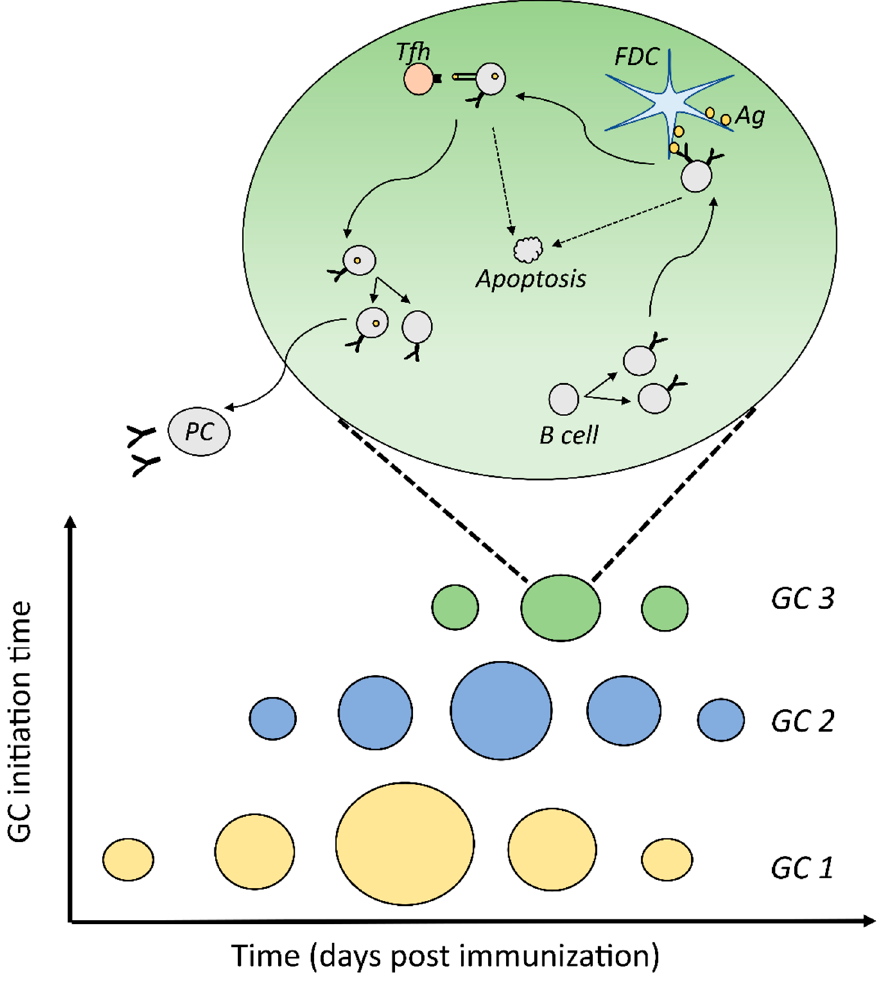
Figure 1. Schematic representation of the simulation of multiple asynchronous GCs. Individual GCs ( GC 1 , GC 2 , and GC 3 ), were initialized at specific time points after immunization and were simulated for several days. Events taking place in individual GCs were modelled using an agent-based representation, where individual cells were simulated. In each GC, B cells proliferated, mutated their antibody genes, collected antigen from FDCs, interacted with Tfh cells, and underwent asymmetric divisions leading to differentiation of plasma cells. Lack of positive selection by FDCs and Tfh cells lead to B cell apoptosis. GC : germinal center; FDC : follicular dendritic cell; Ag : antigen; PC : plasma cell; Tfh: T follicular helper cell.